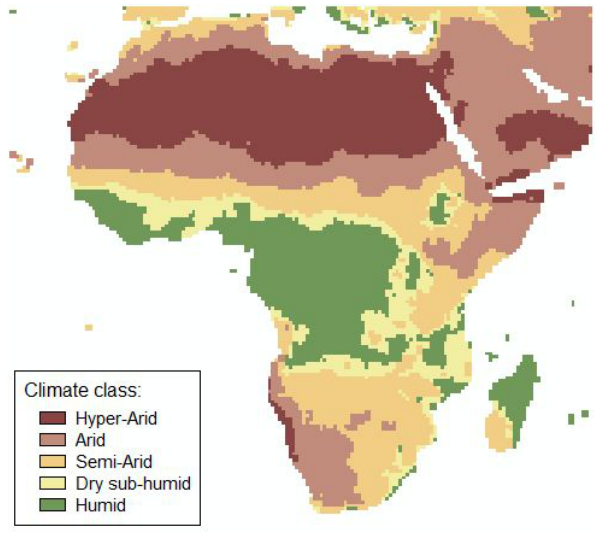
Fig. 1. Derived climate classes for the African continent with a res- olution of 0.5